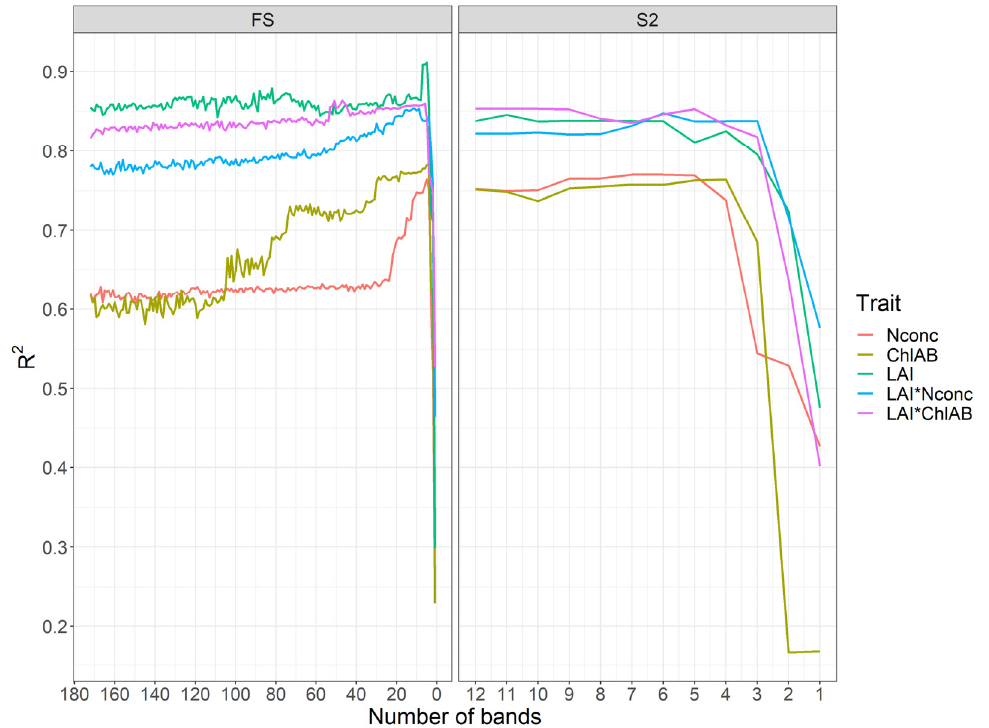
Figure 3. Prediction performance in (R 2 ) for the traits as a function of the number of spectral bands obtained using the Gaussian processes regression–band analysis tool (GPR-BAT) tool with sequential backward band removal (SBBR) algorithm applied (for details on SBBR, see: [86]).